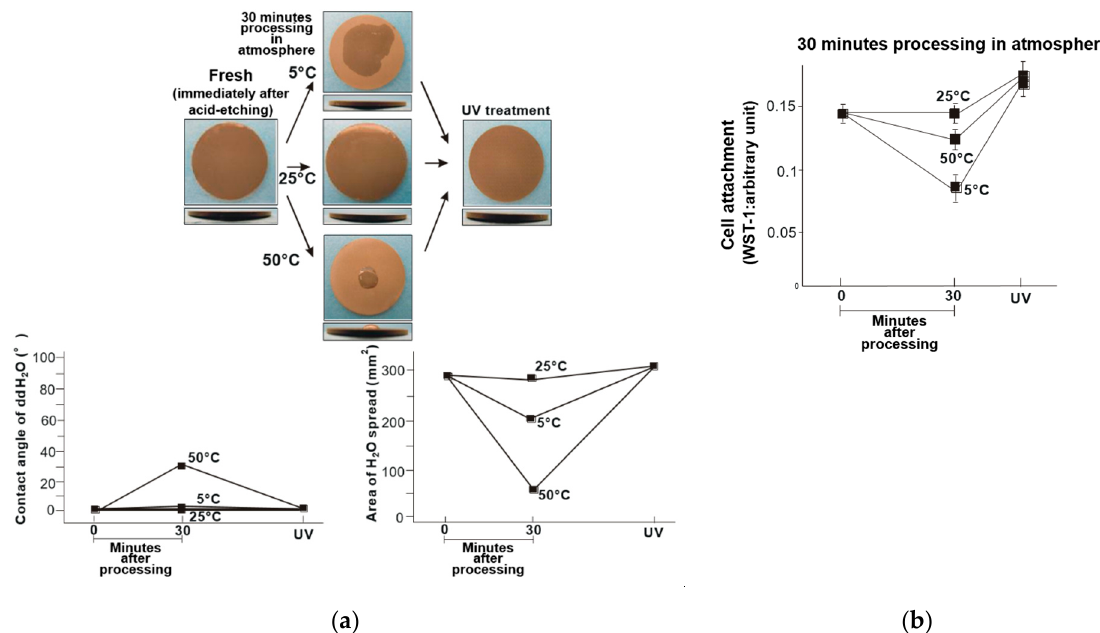
Figure 7. ( a ) Hydrophobicity/hydrophilicity of the UV-treated old–dry titanium disk surfaces illustrated as a photograph of 10 µL ddH 2 O placed on the sample surface before and after temperature deviation (upper middle) with the correspond- ing contact angle (lower left) and spread area (lower right). ( b ) Initial attachment of osteoblasts to the UV-treated old–dry titanium disk surfaces.